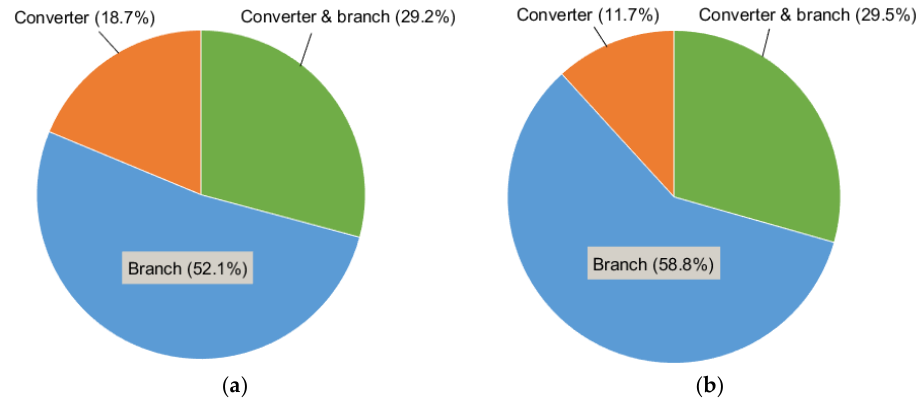
Figure 15. Proportions of shedding sources (Continental Overlay HVDC Grid). ( a ) Number of shedding occurrences; and ( b ) shed power.